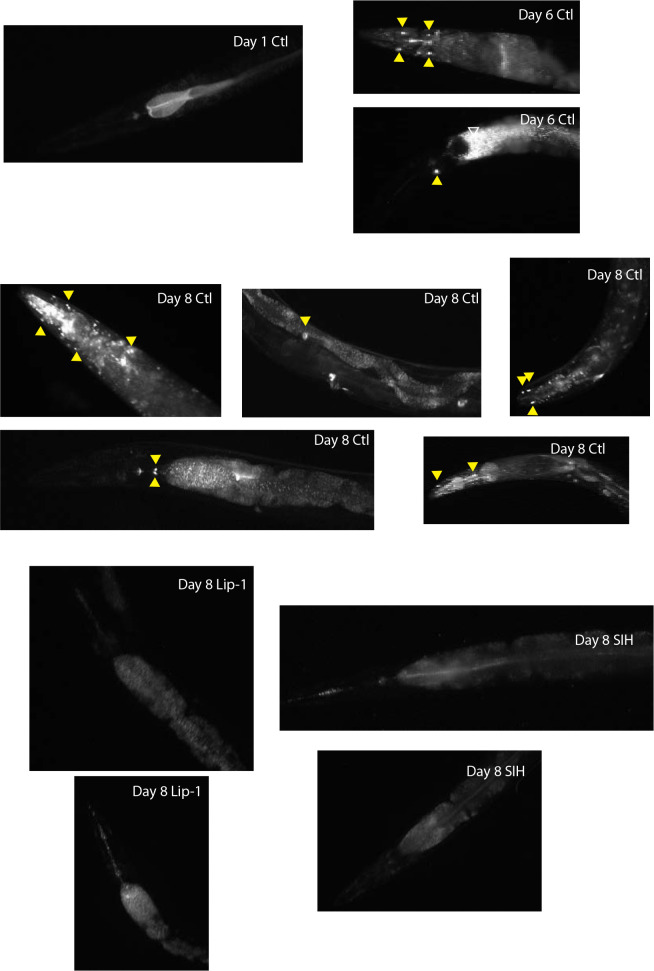
Propidium iodide staining: Cell death observed in aging nematodes.